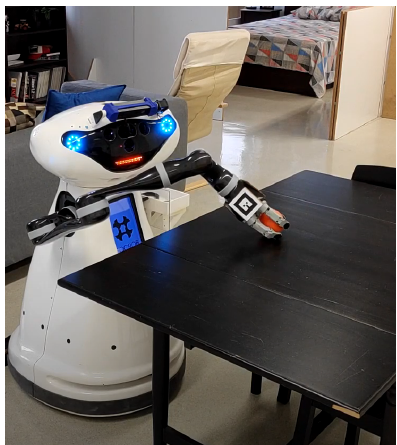
Figure 1. The Mbot mobile robot at the ISR/IST ERL certified test bed performing a pick and place